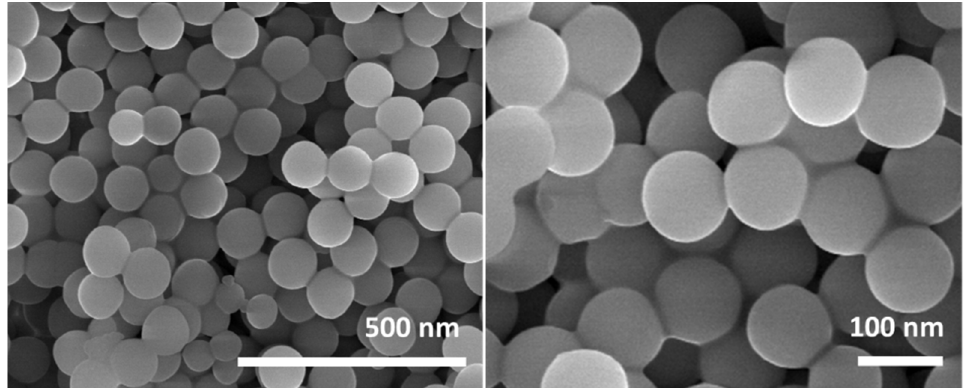
Figure 2. SEM images of the TiO 2 nanoparticles at different resolutions.